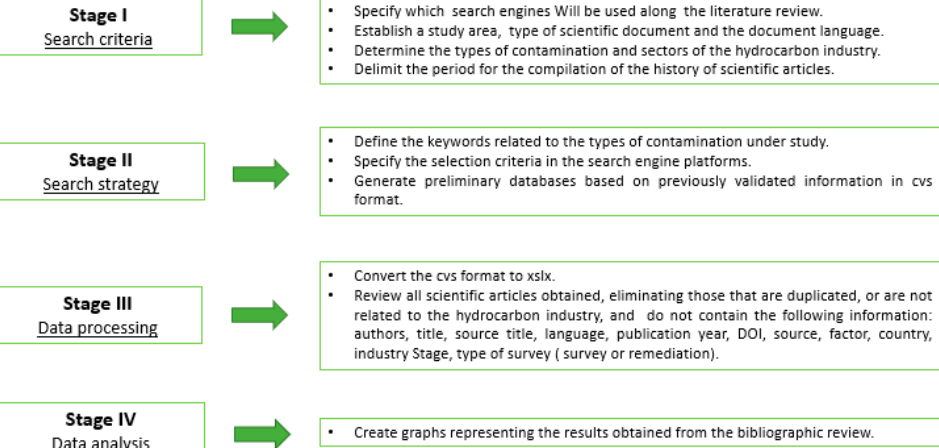
Figure 1. Prisma 2020 inspired flow